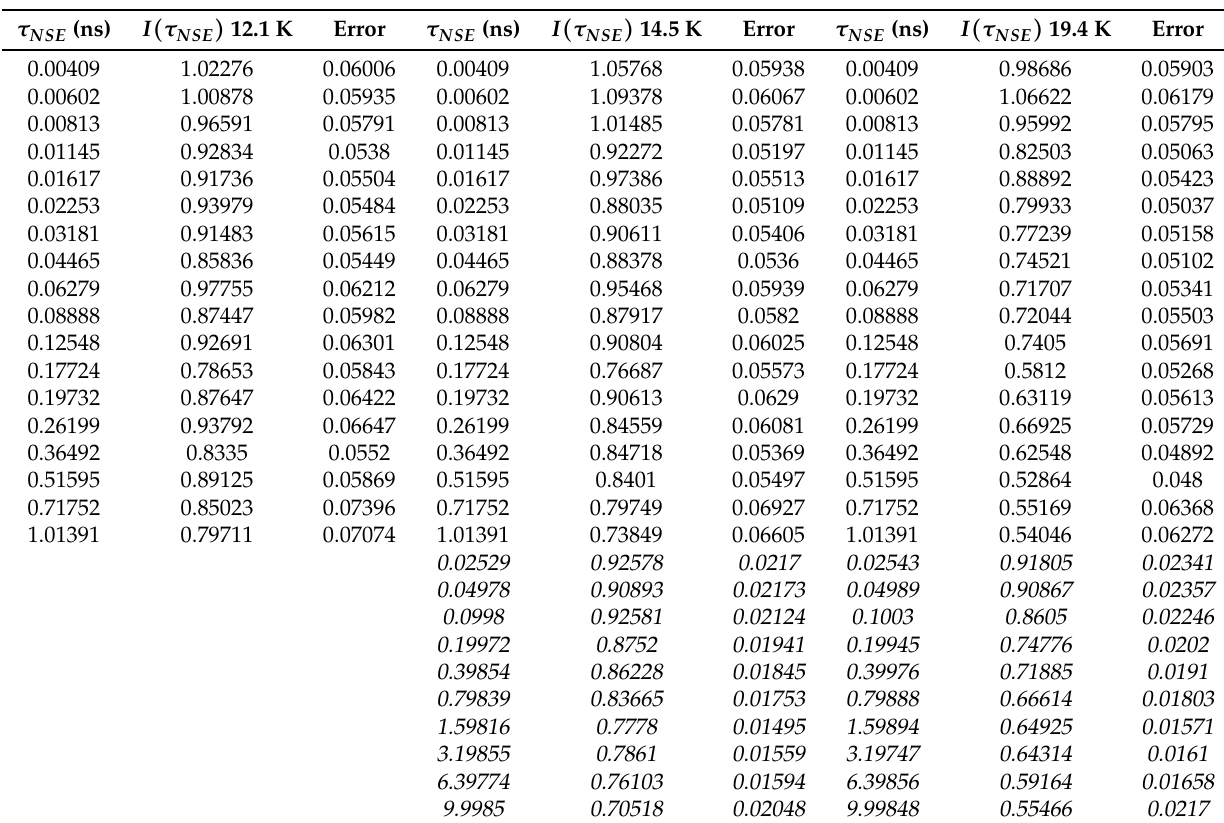
Table 1. Spin echo time τ NSE and values of the intermediate scattering function ( I ( τ NSE ) /error) for all measured temperatures (12.1 ≤ T ≤ 34.2K). The data from RESEDA covers spin-echo times in the range 0 < τ NSE < 1 ns (roman font). The data from J-NSE extends the spin-echo times to approximately 10 ns (slanted font). The data overlap between approximately 0.1 ns and 1